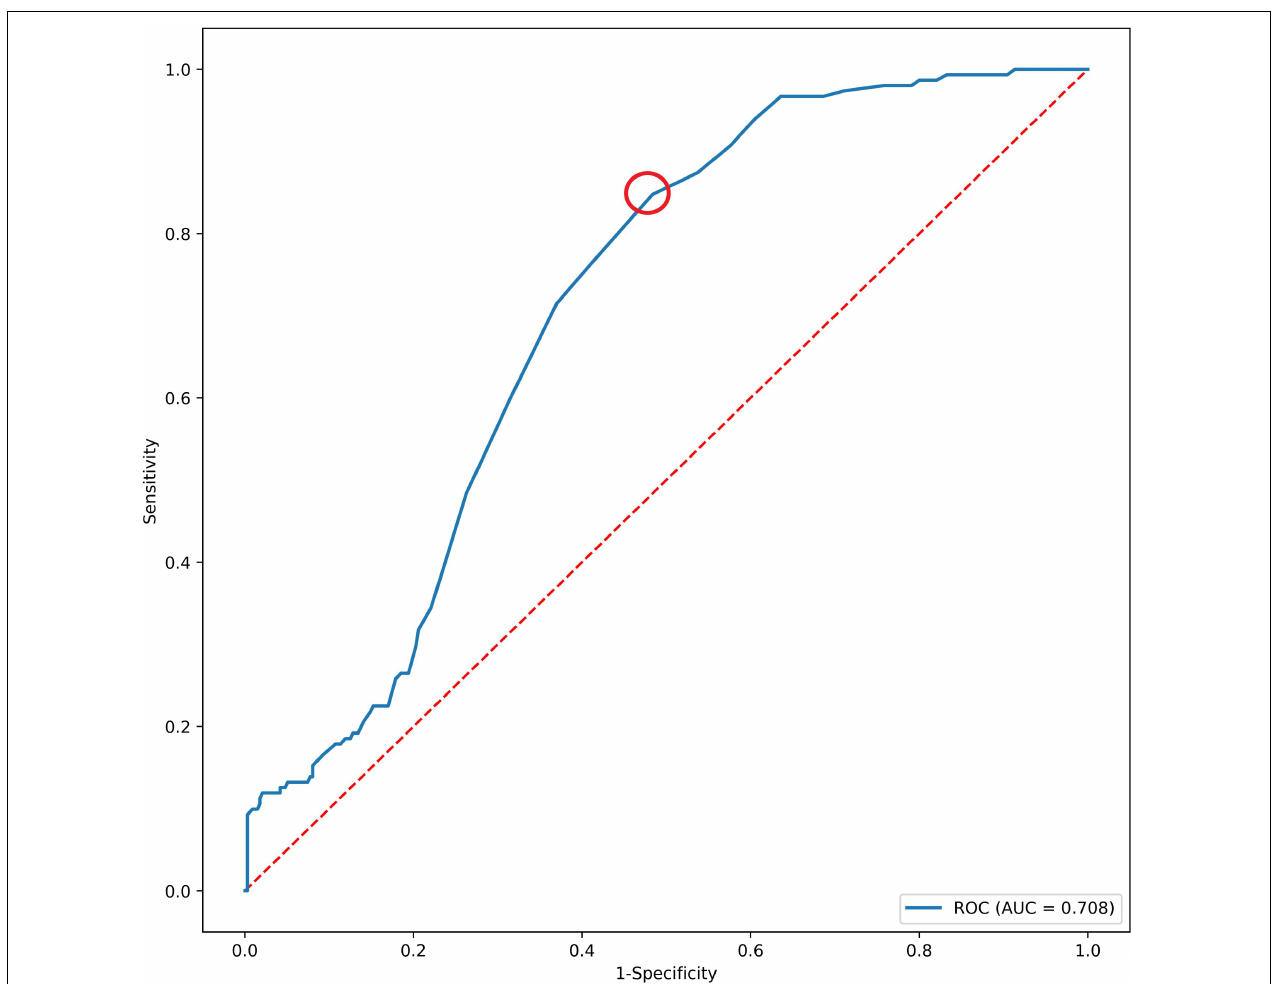
FIGURE 2 | The AUC of CAI and SAEs after EVAR. The red dotted circle represents the optimal cutoff point. AUC, area under the curve; CAI, common iliac artery index; SAEs, severe adverse events.